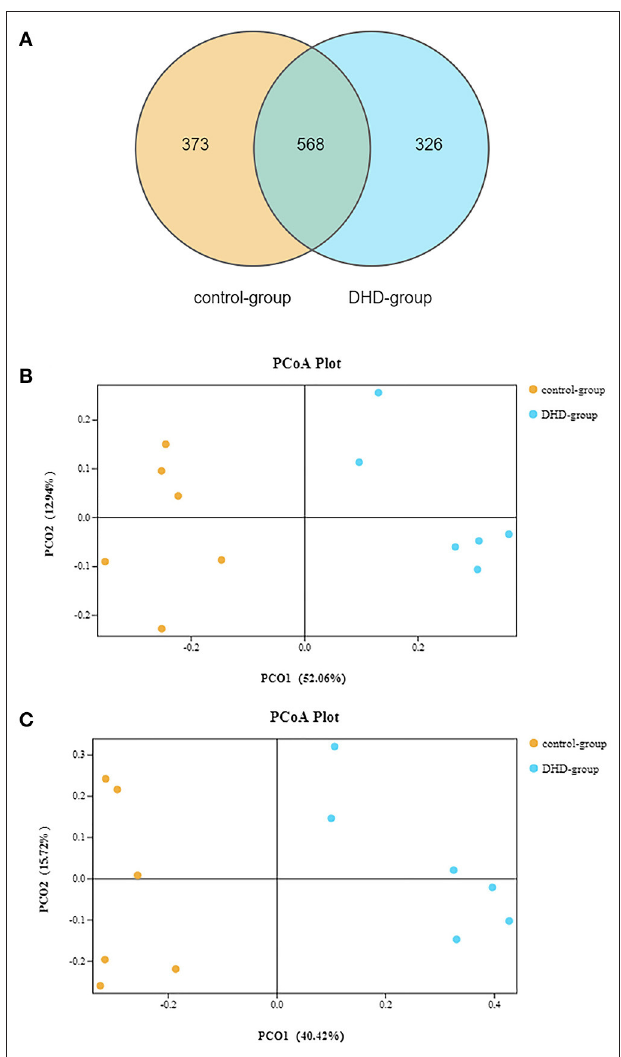
FIGURE 1 | Gut microbial diversity in DHD and healthy calves. (A) Venn diagram showing the number of common or unique OTUs. (B) PCA by the weighted Unifrac of beta diversity of the OTU levels. (C) PCA by Bray-Curtis analysis of beta diversity at the OTU